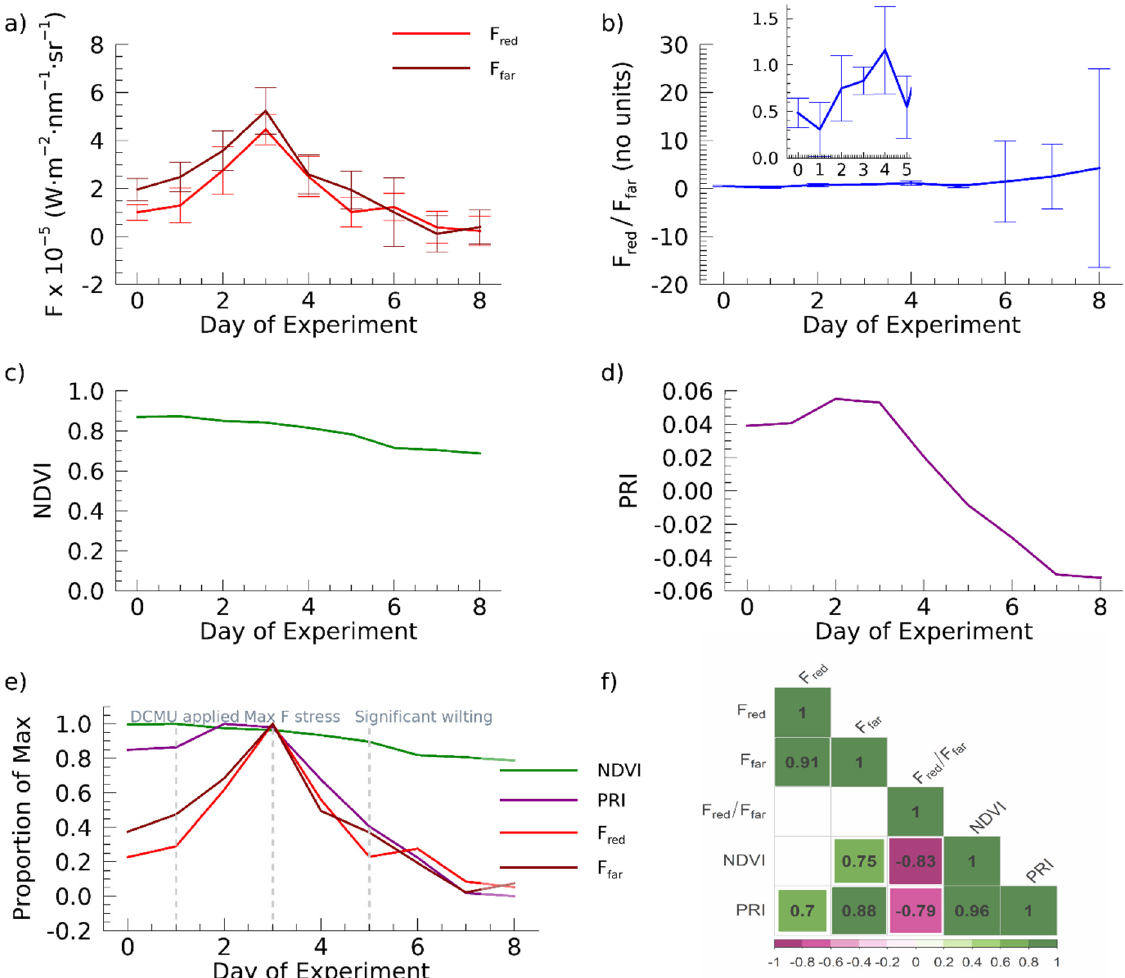
Figure 3. Results of plant stress experiments. CF metrics, NDVI and PRI measurement time series for the experiment. ( a ) Daily mean , F red and F far , ( b ) Daily mean F red /F far , Inset plot of the first five days of the experiment highlighting the trend of increasing F red /F far , ( c ) The normalized difference vegetation index (NDVI) taken one time daily for the experiment. ( d ) The photochemical reflectance index taken one time daily for the experiment ( e ) F red , F far , NDVI, and PRI plotted as the proportion of maximum over the course of the experiment. ( f ) Pearson Correlations among the mean values. Only significant correlations ( p ‐ values < 0.05) are shown along the lower right half. Blank areas in the lower right half indicate insignificant correlations ( p ‐ values > 0.05). Error bars indicate the standard deviation for each day.